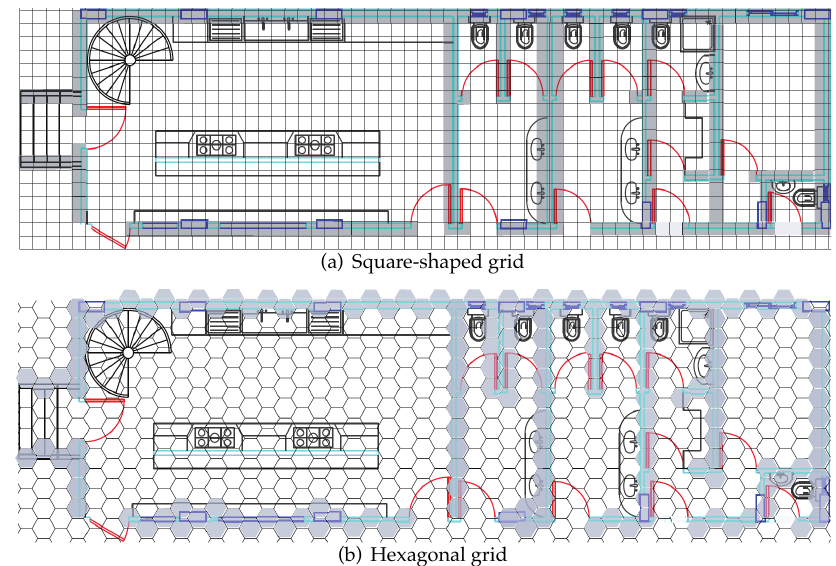
Figure 3: Grid tessellation of a fl oor plan based on either (a) square or (b) hexagonal